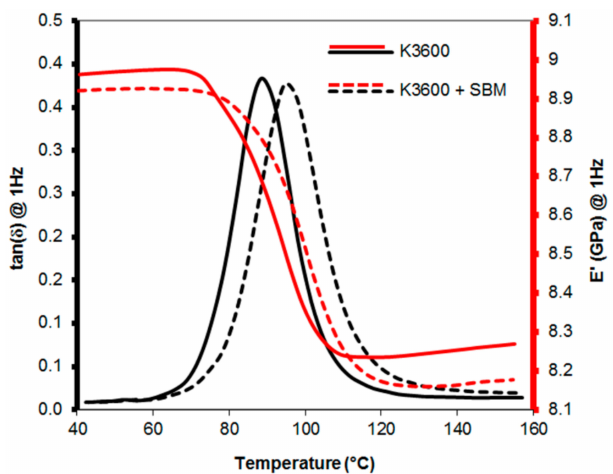
Figure 5. Dynamic Mechanical Thermal Analysis (DMTA) curves for the neat and poly(styrene) –b– poly(butadiene) –b– poly(methylmethacrylate) (SBM) toughened K3600 resins, averaged over the three runs performed at 1 Hz.